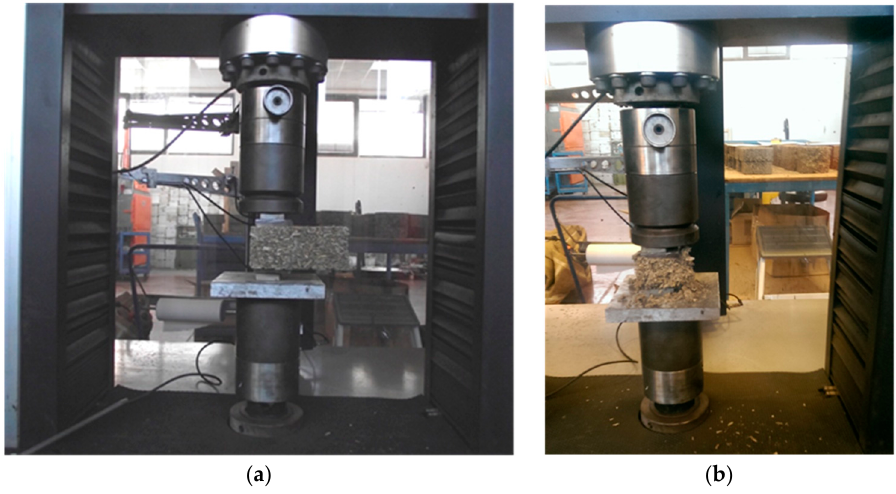
Figure 8. Setup of compression tests: ( a ) half specimen; ( b ) cubic specimen. Table 1. Data from flexural tests.